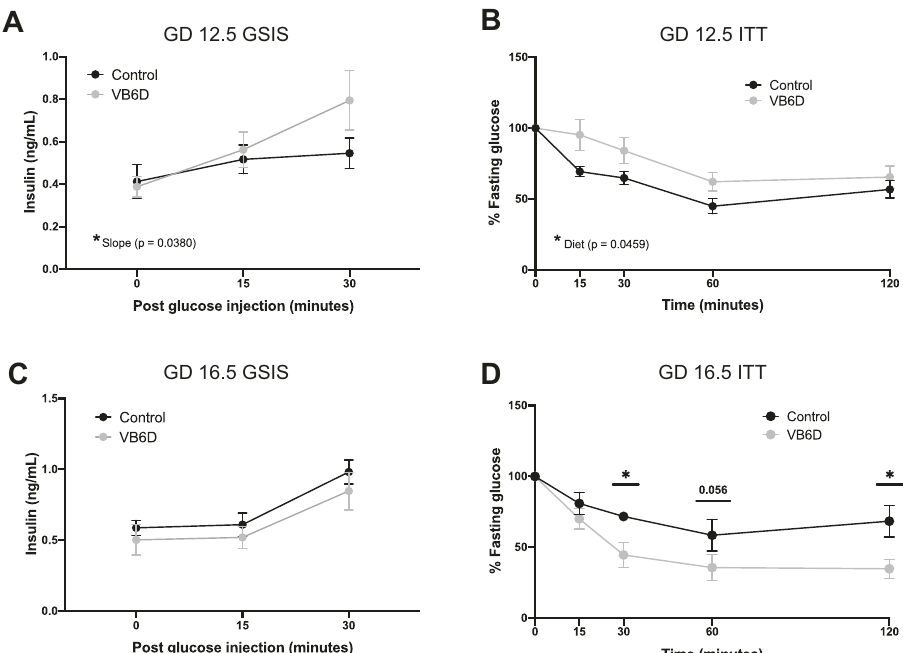
Fig. 2 Vitamin B6-de fi cient dams have normal insulin secretion, but heightened insulin sensitivity during pregnancy. At GD 12.5, VB6D dams have normal fasting insulin levels and insulin secretion response when glucose challenged compared to controls ( A ). At GD 12.5, VB6D has decreased insulin sensitivity compared to control ( B ). At GD 16.5, VB6D dams have normal fasting insulin levels and insulin secretion response when glucose challenged compared to control ( C ). At GD16.5, VB6D dams are more insulin sensitive compared to control indicated by a more signi fi cant reduction in glucose compared to controls ( D ). Data represent 5 – 8 mice per treatment group. Analysis of all panels was done by a two-way, repeated-measures ANOVA. A main effect of diet was observed in panel ( B ). In panel D , we identi fi ed a diet × time interaction effect, and a post hoc Holm – Sidak ’ s test was subsequently conducted which revealed that the percent fasting glucose at T = 15 and 30 min were signi fi cantly different between the groups. * p ≤